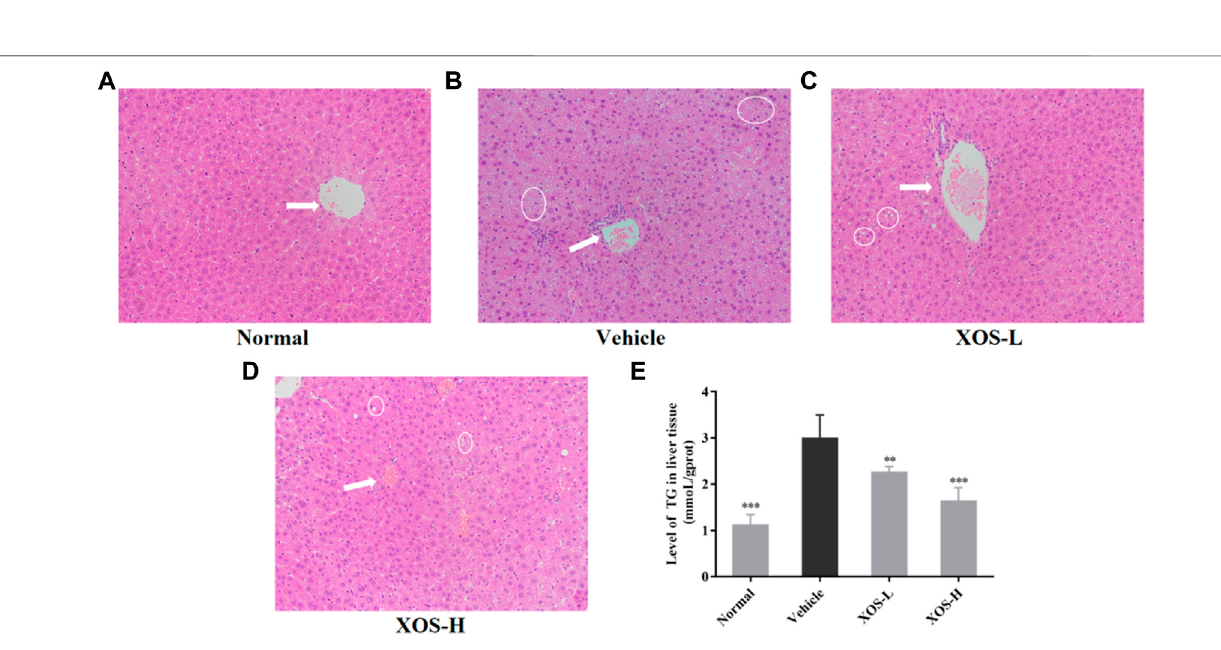
FIGURE 4 | (A – D) Effect of XOS supplementation on H&E pathological observation of liver tissue in mice. Magni fi cation 10 × ; (E) Level of TG in liver tissue. XOS-L: mice treat with XOS 250 mg/kg, XOS-H: mice treat with XOS 500 mg/kg. The arrow indicates the central vein, the circled indicates lipid drop. ** p < 0.01, *** p < 0.001 compared with the Vehicle